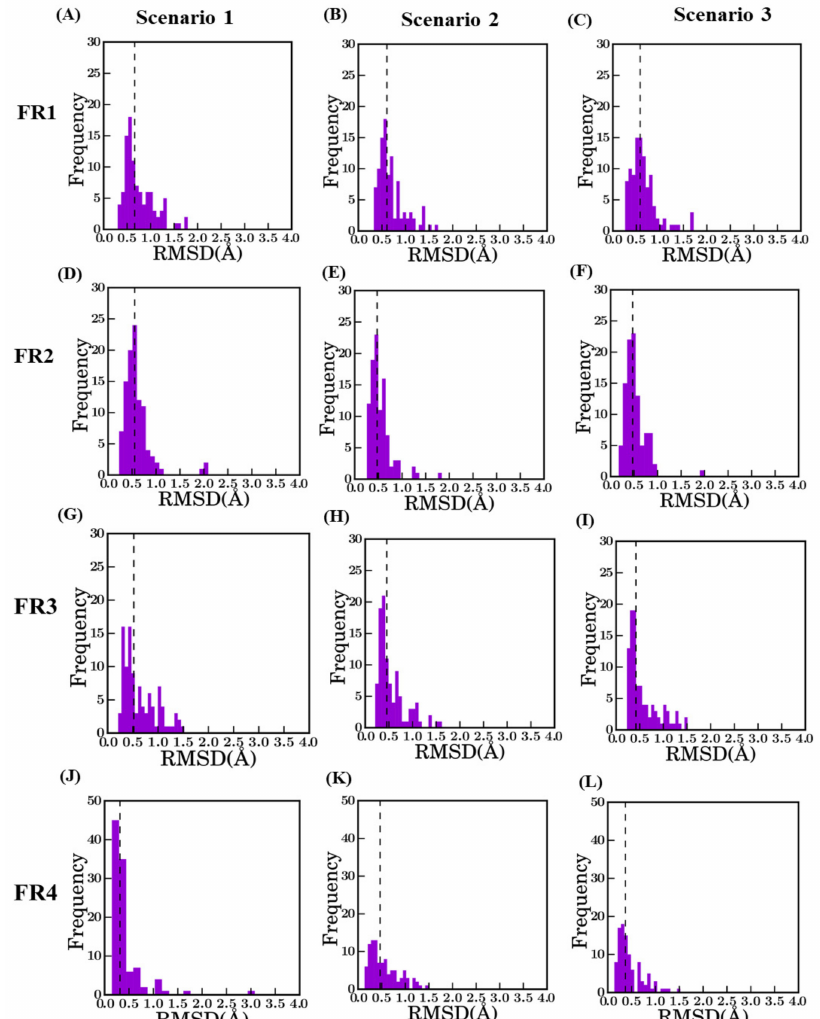
Figure A8. Distribution of RMSD in FR between best model and crystal structure. The dotted line represents the median value in each plot; they are indicated in brackets. FR1 ( A – C ), FR2 ( D – F ), FR3 ( G – I ), and FR4 ( J – L ) with scenario 1 ( A : 0.66 Å, D : 0.56 Å, G : 0.52 Å, and J : 0.32 Å), scenario 2 ( B : 0.61 Å, E : 0.4 Å, H 0.45 Å and K 0.47 Å) and scenario 3 ( C : 0.58 Å, F : 0.47 Å, I : 0.42 Å, and L : 0.37